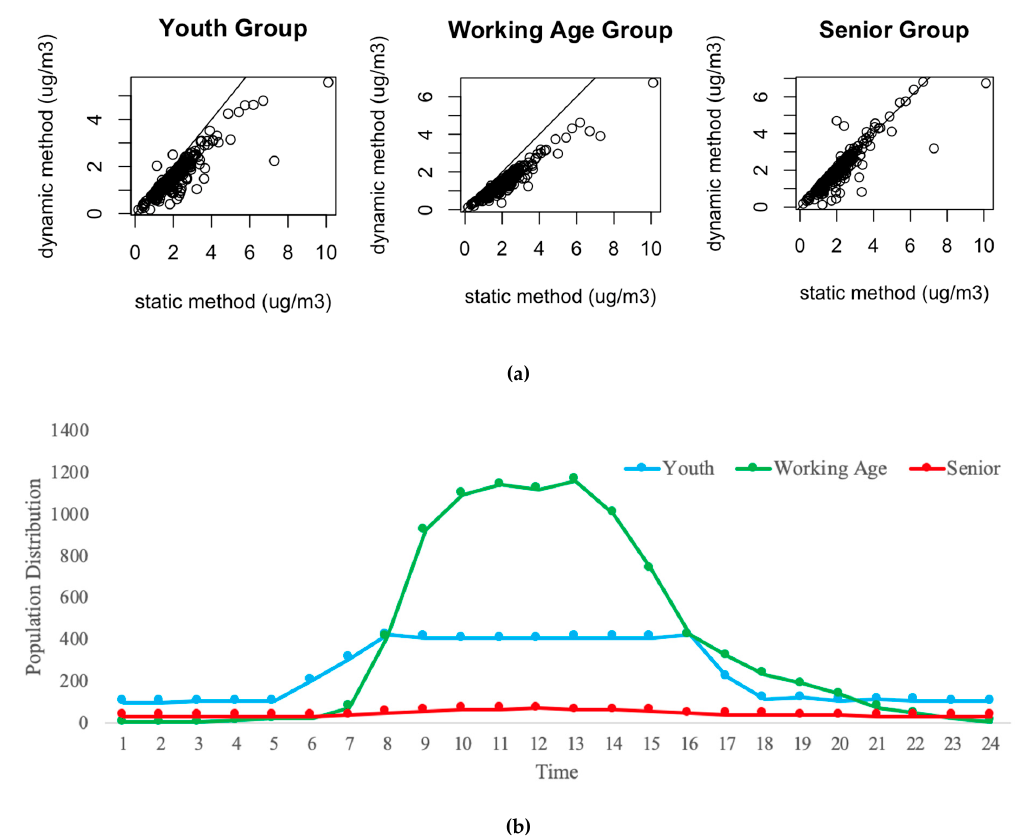
Figure 7. Comparison between dynamic and static method in different age groups. ( a ) Comparison of population-weighted concentrations (all TAZs, the black line is y = x), ( b ) Comparison of population distribution in different age groups (TAZ 144).